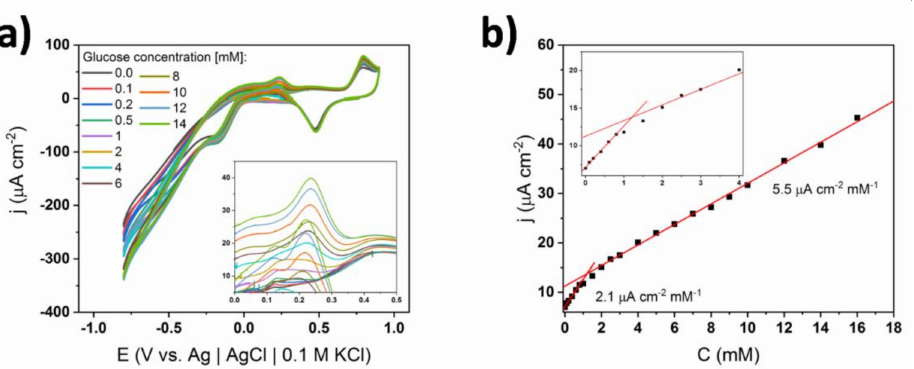
Figure 12. ( a ) Cyclic voltammograms of TiND | AuNP non-coated electrode registered for di ff erent glucose concentrations in 0.1 M sPBS; inset—magnification of glucose oxidation peaks, ( b ) calibration curve based on glucose oxidation peak at + 0.35